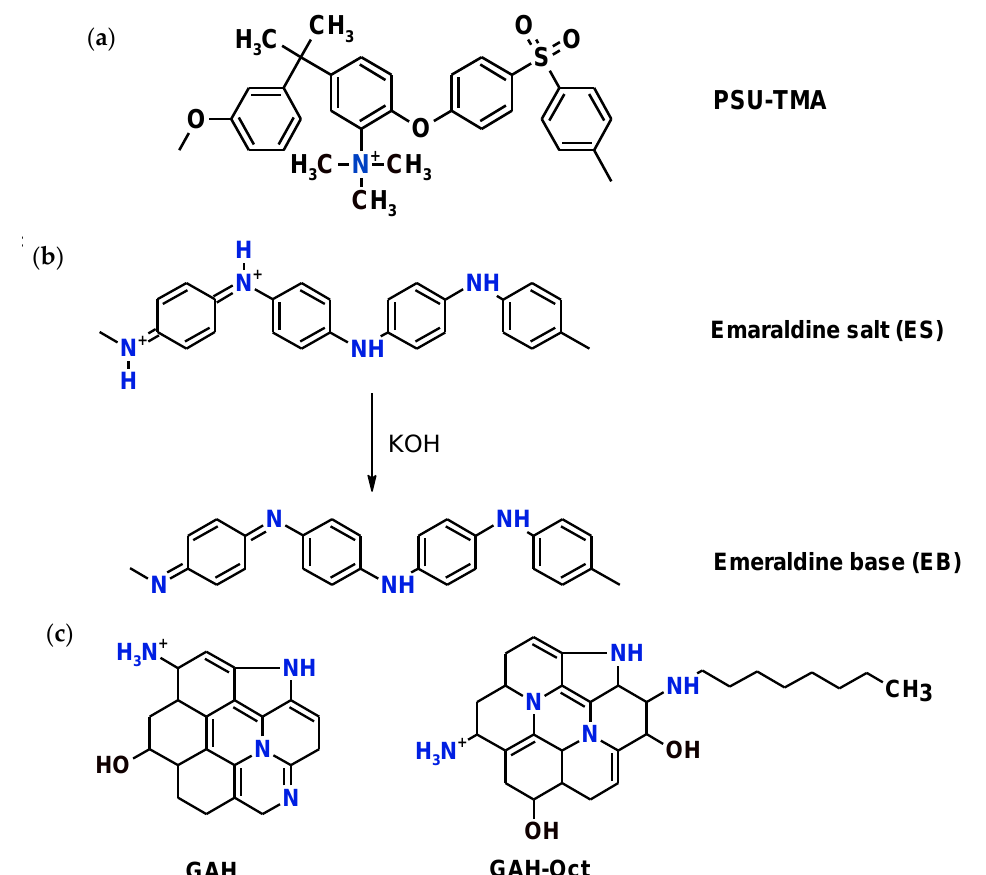
Scheme 1. Chemical formulas of ( a ) PSU-TMA, ( b ) PANI (emeraldine salt and base) and ( c ) simplified plified structures of CQD. structures of